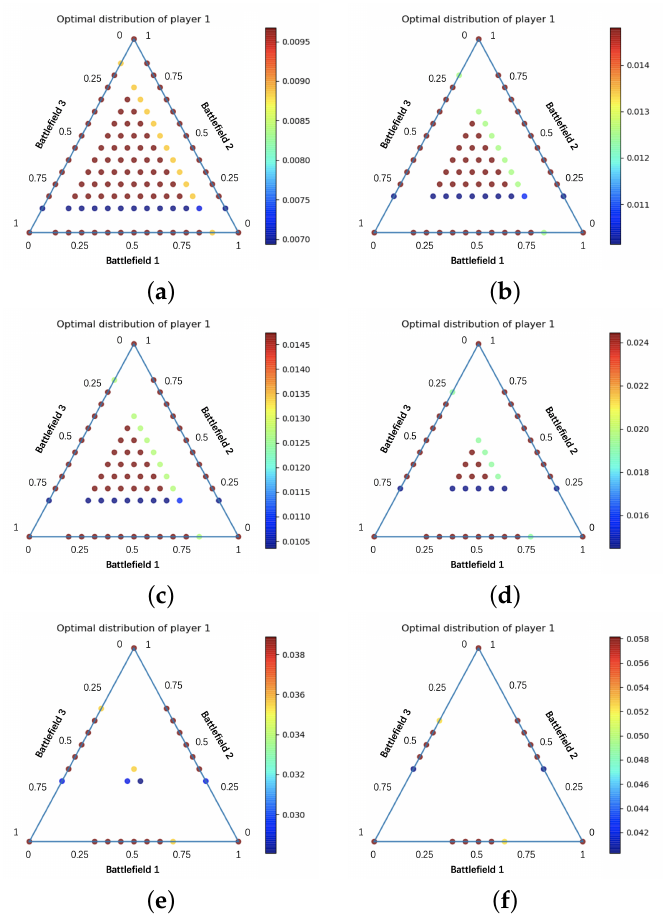
Figure 6. Optimal distribution of Player 1 corresponding to different M . Each point is a sub-strategy, and its 3D coordinates represent the proportion of force allocated on the three battlefields. Its color denotes the weight of this sub-strategy among all sub-strategies. If more sub-strategies are located in the middle of the triangle, both sides of the confrontation tend to allocate their force equally across the three battlefields. If more sub-strategies are allocated on the axis of the triangle, both sides prefer to allocate force on only one or two battlefields. ( a ) M = 15; ( b ) M = 20; ( c ) M = 25; ( d ) M = 30; ( e ) M = 35; ( f ) M =